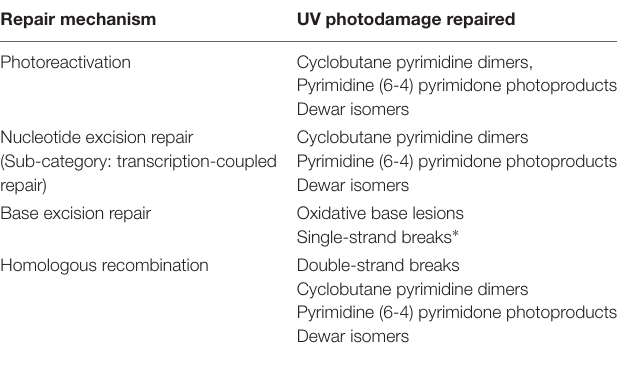
TABLE 1 | DNA repair systems that address UV-induced damage, all of which have been researched in halophilic archaea, ∗ with the exception of single-strand break